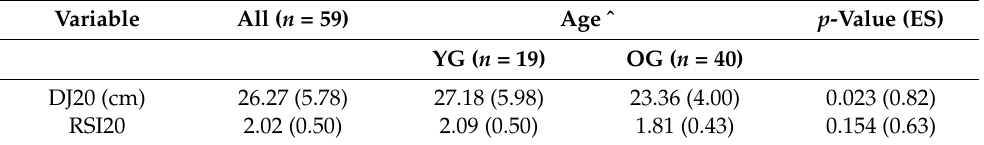
Table 3. Drop jump (DJ) performance parameters ( ± SD) and reactive strength index regarding age. Variable All ( n = 59)